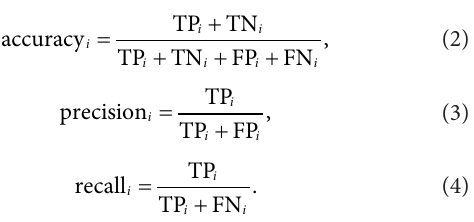
FigUre 8 | (a) A representative novel gaze object sequence is shown. The colors in the figure correspond to the color-coded objects in Figure 1c . (B) A DBA gaze object sequence is shown for Subtask 4, which is the correct subtask label for the novel gaze object sequence shown in panel (a) . (c) The DTW Euclidean distance is shown for the comparisons of a novel gaze object sequence and the DBA sequence for each of the six subtasks. The DTW distance was calculated using equal elapsed times for the novel and DBA sequences. The lowest DTW distance would be used to apply a subtask label. Subtask recognition accuracy generally increases as the elapsed sequence time